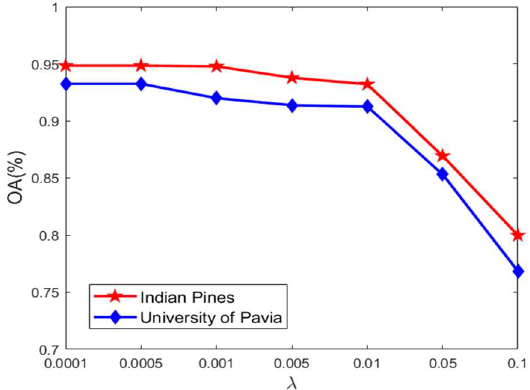
Figure 6. Impact of the low rank constraint parameter λ .